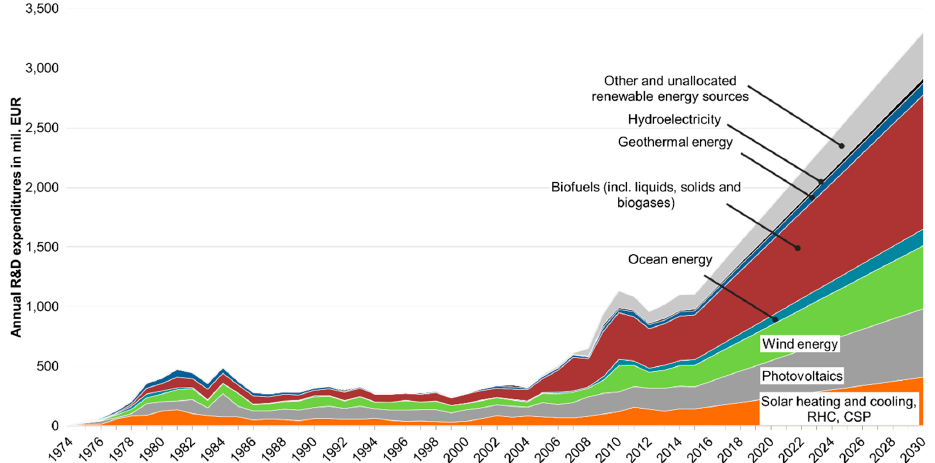
Figure 2. Renewable energy sources R&D expenditures of the EU MS from 1974 to 2015 and estimated until 2030 (Mil. EUR, Advanced scenario) (2014 prices and exc. rates).